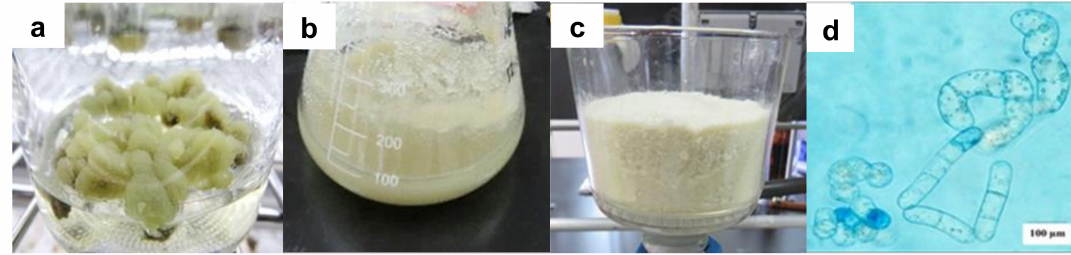
Figure 1. Cell culture from Ageratina pichinchensis leaves. ( a ) Friable callus at 20 days of culture; ( b ) cell suspension culture with abundant biomass at 16 days of culture; ( c ) filtered biomass; ( d ) microscopic image of cell suspension culture (100 ×